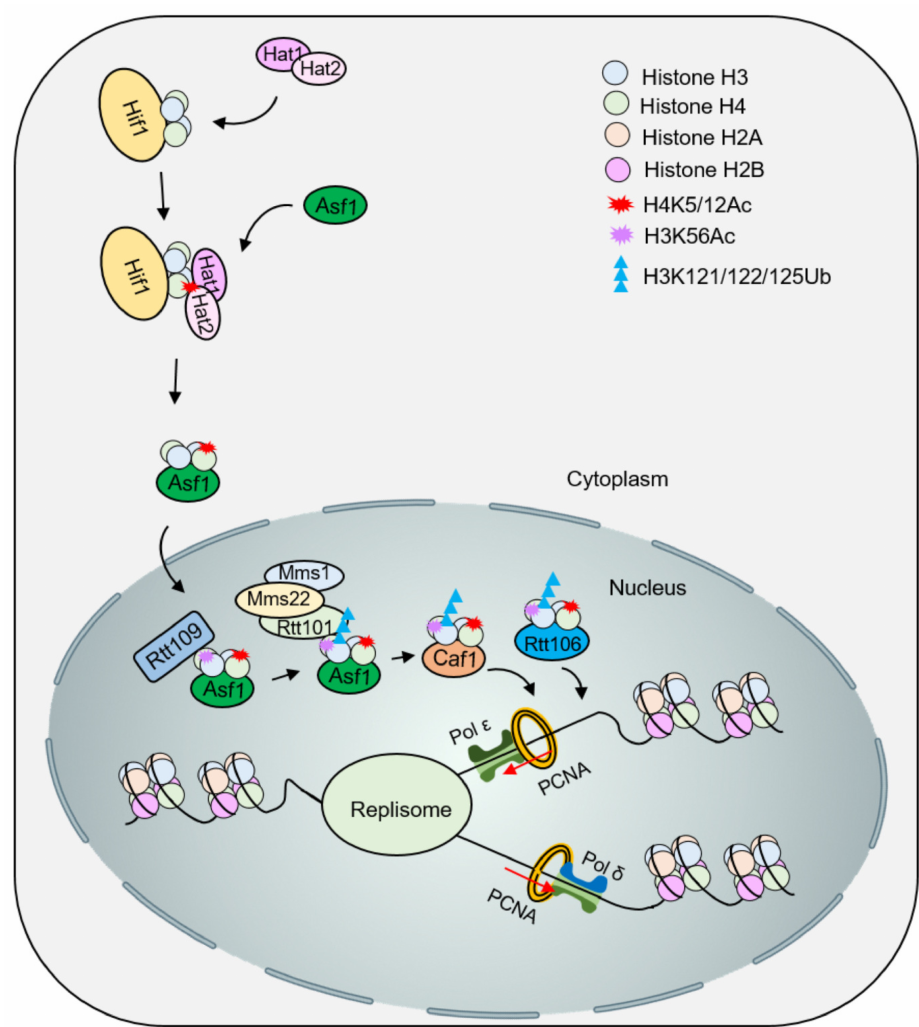
Figure 3. The function of histone modification in nucleosome assembly in yeast. The new H3–H4 is acetylated by the acetyltransferase Hat1/Hat2, and Asf1 promotes nuclear import of H3-H4K5/12ac. Subsequently, acetylation of H3K56 by Rtt109-Vps75 promotes ubiquitination of H3K121/122/125 by Rtt101 Mms1/Mms22 . The modified H3-H4 dissociates from Asf1 and is presented to the chaperones Caf1 and Rtt106 to deposit histones on DNA for nucleosome